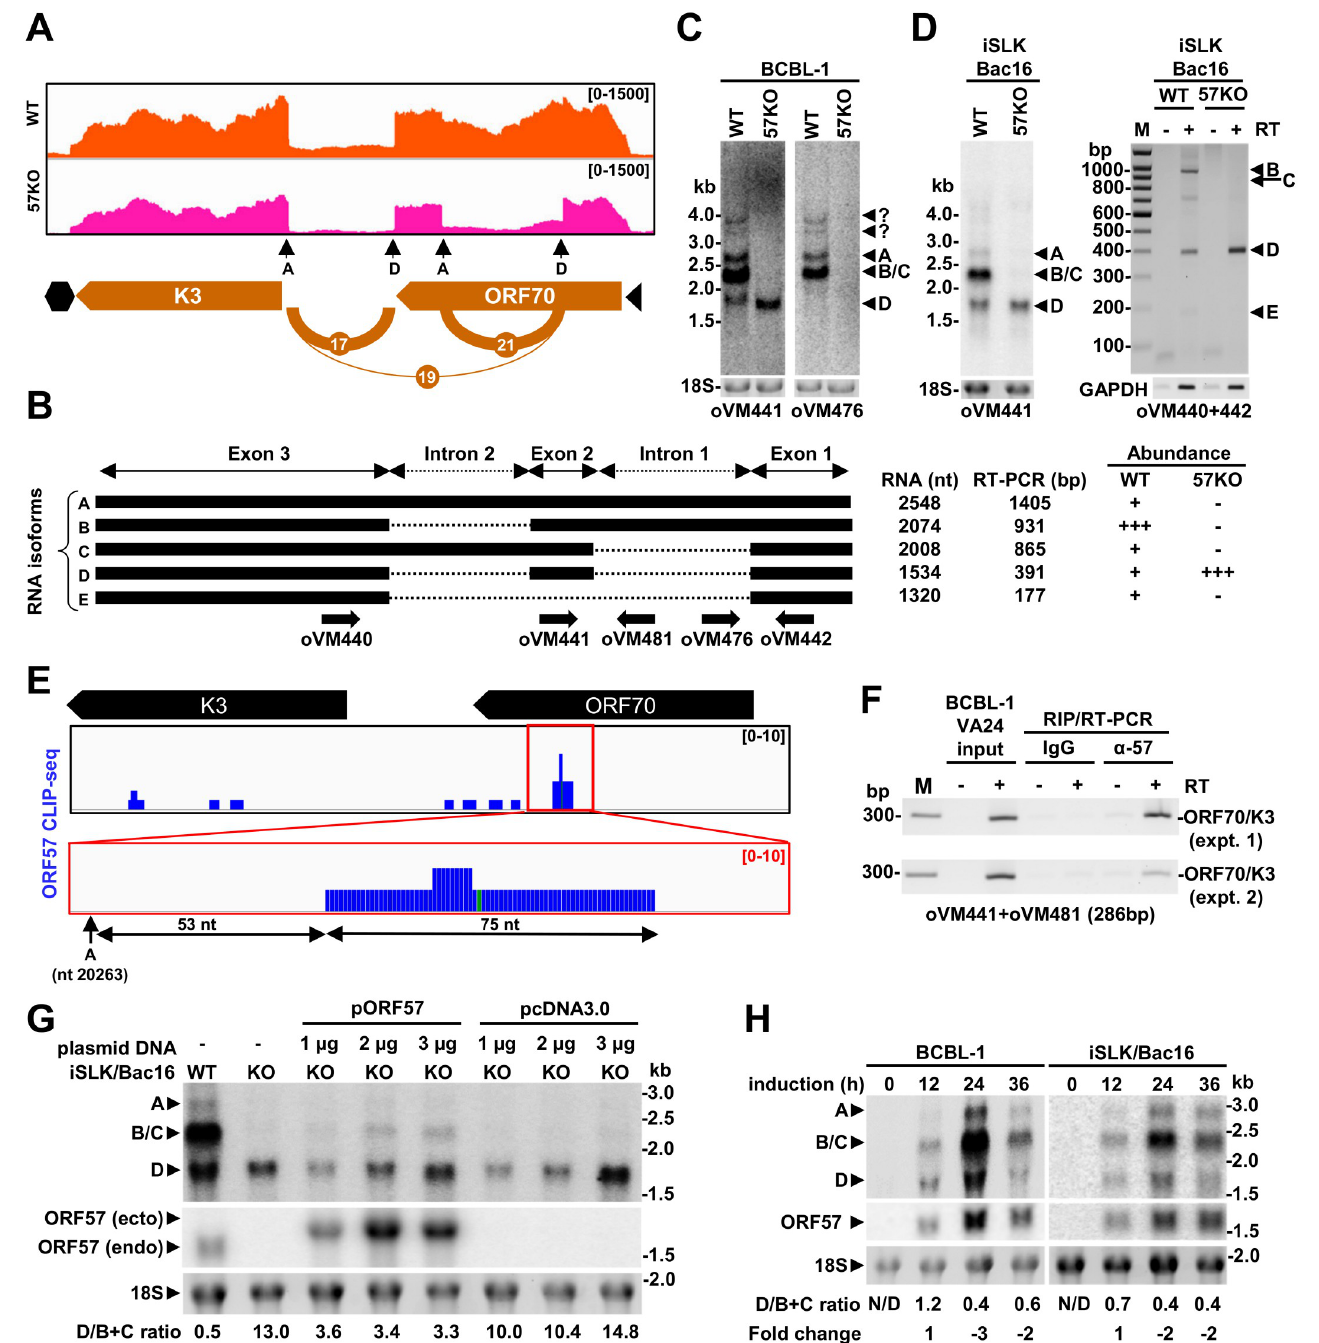
Fig 10. Regulation of ORF70/K3 RNA alternative splicing by ORF57. (A) The most prevalent splice junctions and RNA-seq reads-coverage of ORF70/K3 transcripts from the WT genome (orange) and the 57KO genome (pink) in BCBL-1 cells during KSHV lytic infection. (B) Diagrams of major ORF70/K3 splicing isoforms. Black boxes represent the exons and dashed lines the introns. The arrows below represent oligos used in Northern blot and RT-PCR (see S6 Table for the details). On the right are predicted sizes of all spliced isoforms and their relative abundance in the cells with the WT or 57KO genome. (C and D) Northern blot analysis of ORF70/K3 splicing isoforms expressed from the WT and 57KO genomes in BCBL-1 (C) and iSLK/Bac16 (D) cells with KSHV lytic replication. Total cell RNA was extracted and examined by Northern blot using two separate 32 P-labeled oligo probes (oVM441 and oVM476) (C and D) or by RT-PCR using a primer set of oVM440 and oVM442 shown in (B) in the absence (-) or presence (+) of reverse transcriptase (RT) (D, right panel and S2C Fig ). The 18S rRNA in Northern blot and GAPDH RNA in RT-PCR analyses indicate the amount of total RNA in individual sample loading. (E-F) ORF57 binding to ORF70/K3 RNA. (E) Distribution of ORF57 CLIP-seq reads (blue) mapped to the ORF70/K3 locus. The red box marks the zoomed-in area shown below. The ORF57 CLIP-seq was described in our